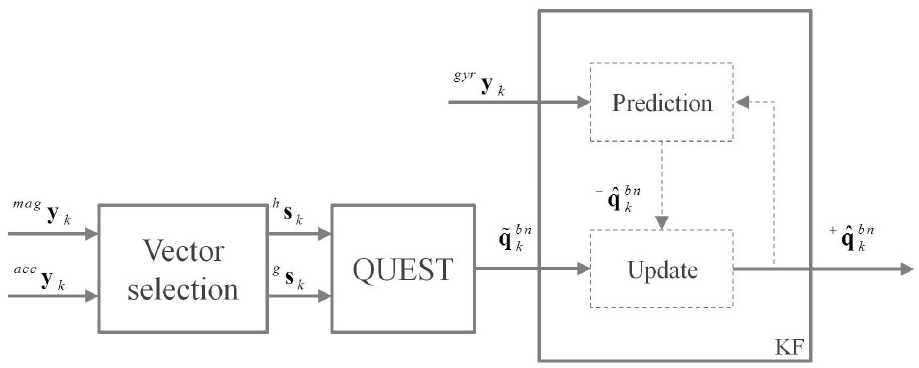
Figure A1. Overall workflow of the orientation estimator proposed in [35].